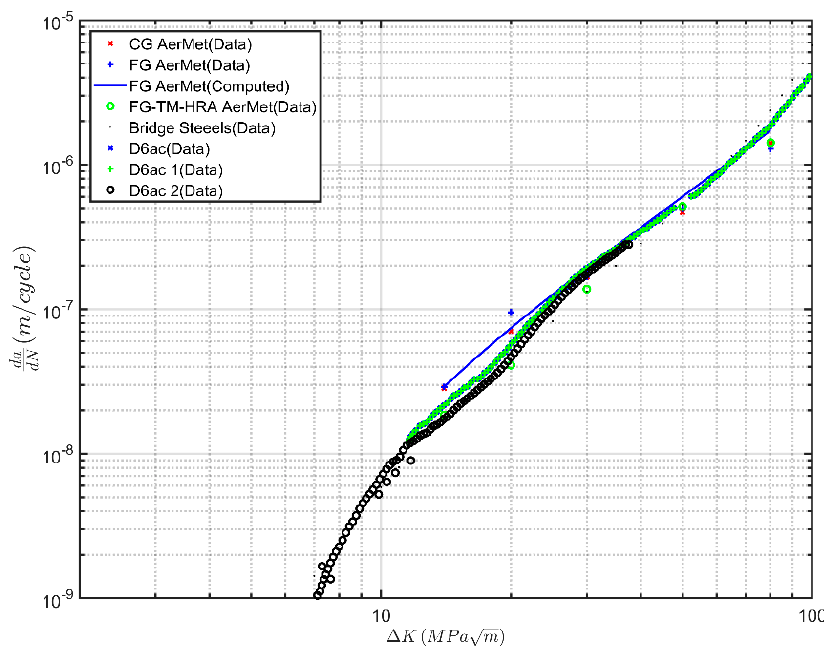
Figure 12. Measured and computed R = 0.1 crack growth curves for additively manufactured AerMet 100 and comparison with the crack growth curves for conventionally manufactured AerMet 100, D6ac steel and bridge steels.